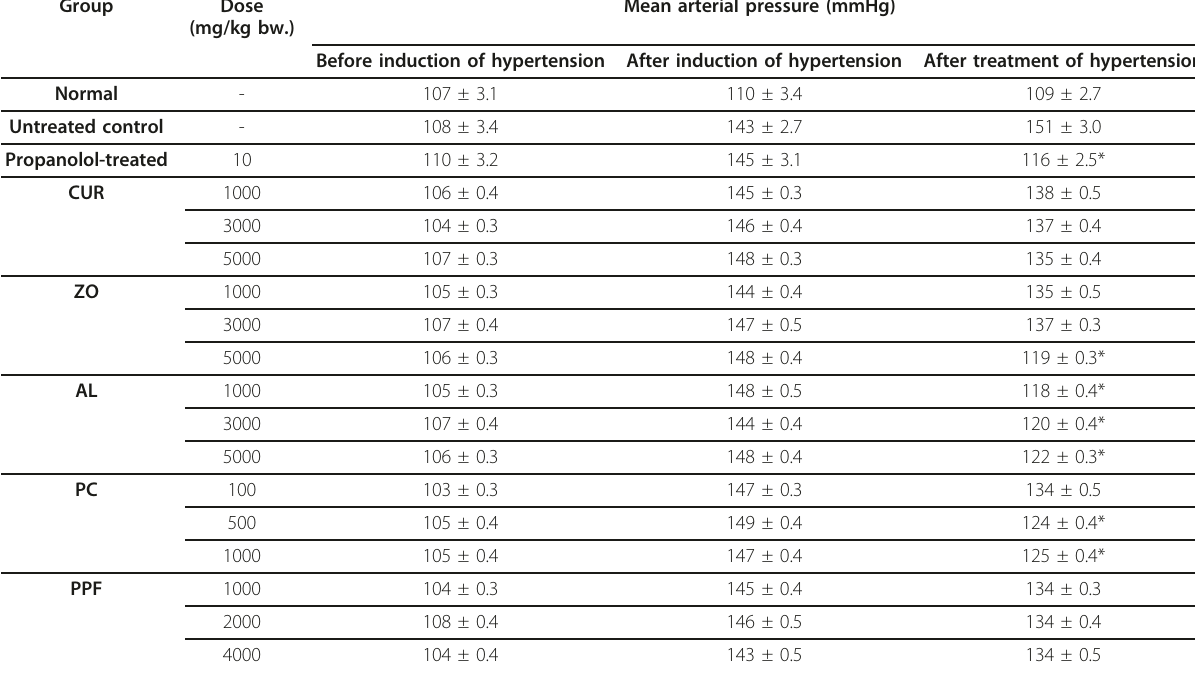
Data are presented as mean ± SEM values *Statistically significant difference with baseline by paired t-test: sBP and dBP of ZO-treated group at high dose level (p < 0.001) sBP and dBP of AL-treated group at all dose levels (p < 0.001) sBP and dBP of PC-treated group at medium and high dose levels (p < 0.001) sBP and dBP of propanolol-treated group (p <